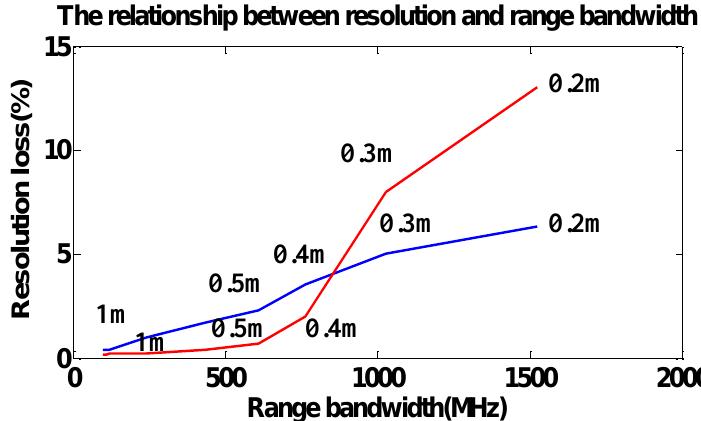
Figure 10. The relationship between PSLR loss and range bandwidth weighting in the range time domain. The blue line shows the PSLR loss in the azimuth direction and the red line shows the PSLR loss in the range direction. The numbers beside the line show the two-dimensional theoretic resolution.